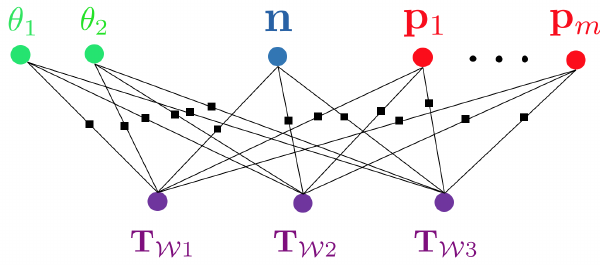
Figure 3. Factor graph corresponding to the example shown in Figure 2. Each factor in the graph (indicated by a black box) represents a residual error from an incidence relationship between measurements and a combination of a camera pose and some object or background geometry related parameters.